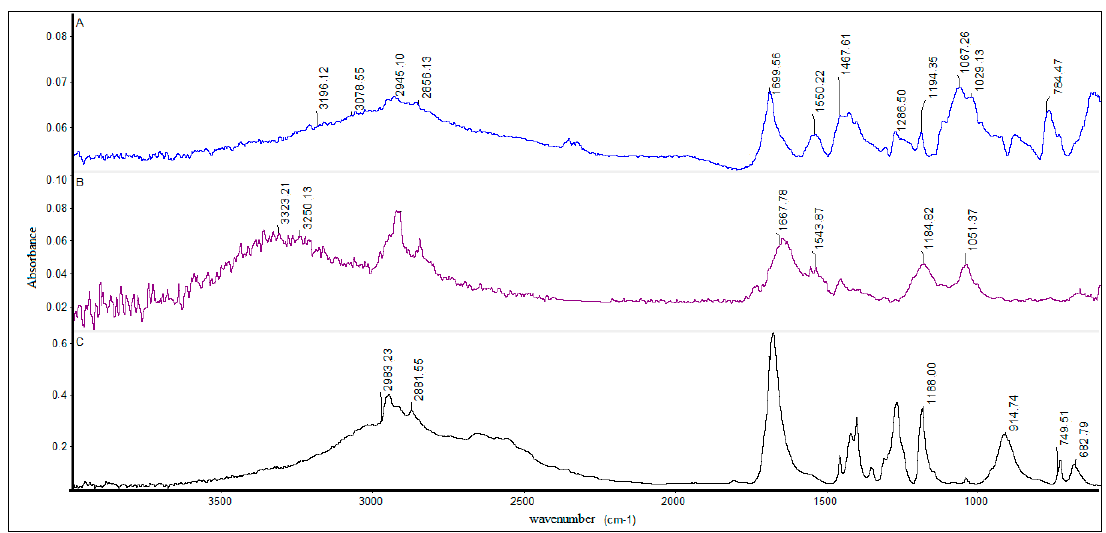
Figure 5. The number of adult forms in the intestine (5 DAI) and larvae × 10 2 /g of mice muscle tissue (30 DAI) in mice infected with T. spiralis ; NB: newborn larvae delivered by females isolated from control infection; NB(Ch): newborn larvae delivered by females isolated from mice infected and treated with chitosan. (*) p < 0.05, chitosan vs. infected.